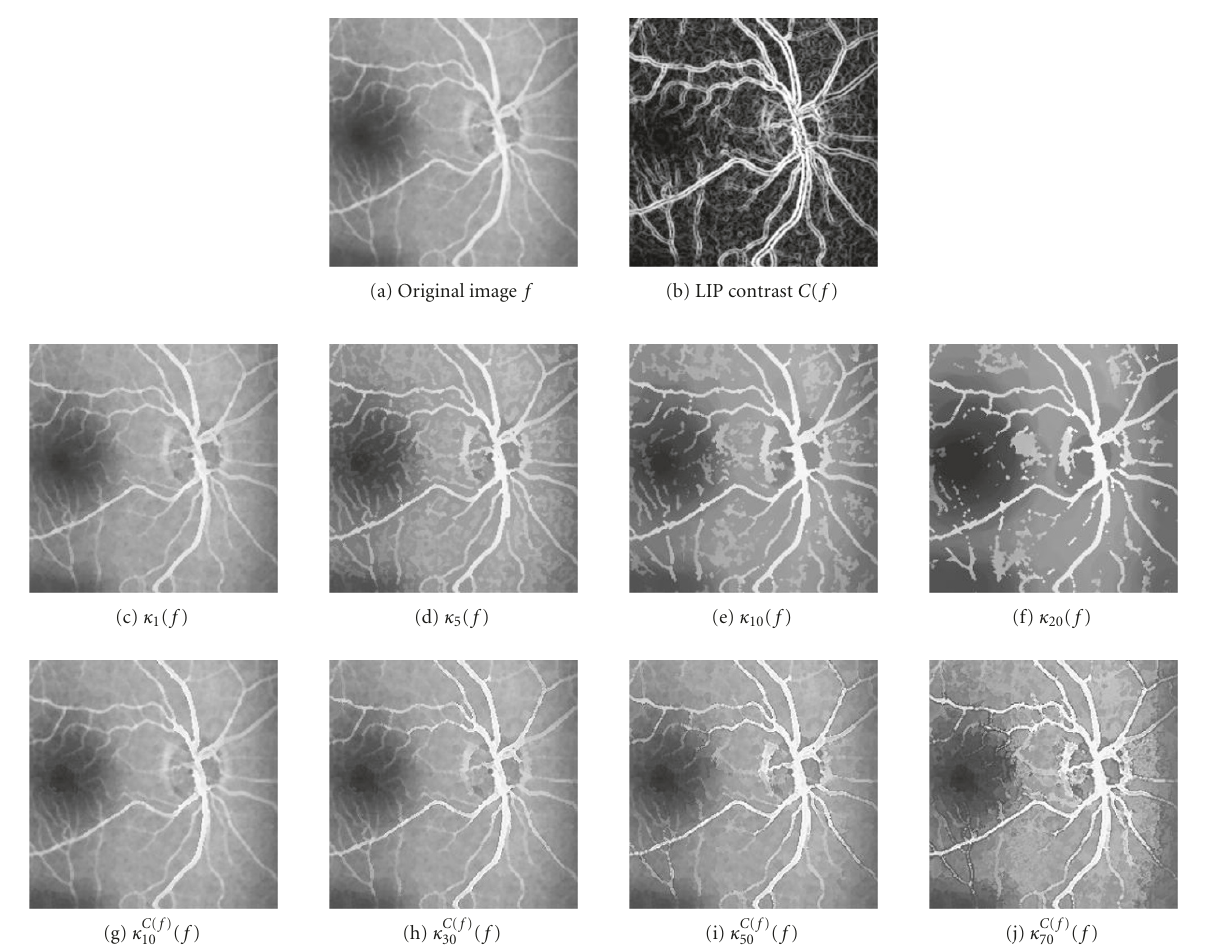
Figure 11: Image enhancement through the toggle contrast process. The operator is applied on a real (a) image acquired on the retina of a human eye. The enhancement is achieved with the usual toggle contrast (c)–(f) and the LANIP-based toggle LIP contrast (g)–(j). Using the usual toggle contrast, the edges are disconnected as soon as the filtering becomes too strong. On the contrary, such structures are preserved and sharpened with the LANIP